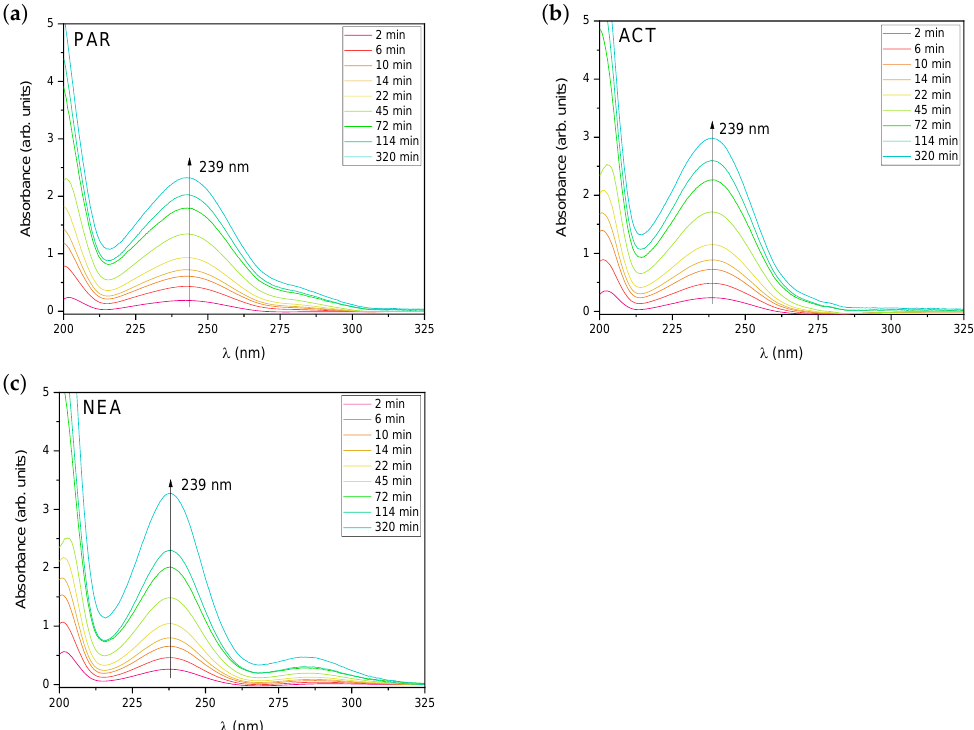
Figure 6. Changes in absorption spectra of ( a ) PAR, ( b ) ACT, and ( c ) NEA during release from PU/polyethylene glycol (PEG) 4000 hydrogel at room temperature (25 ◦